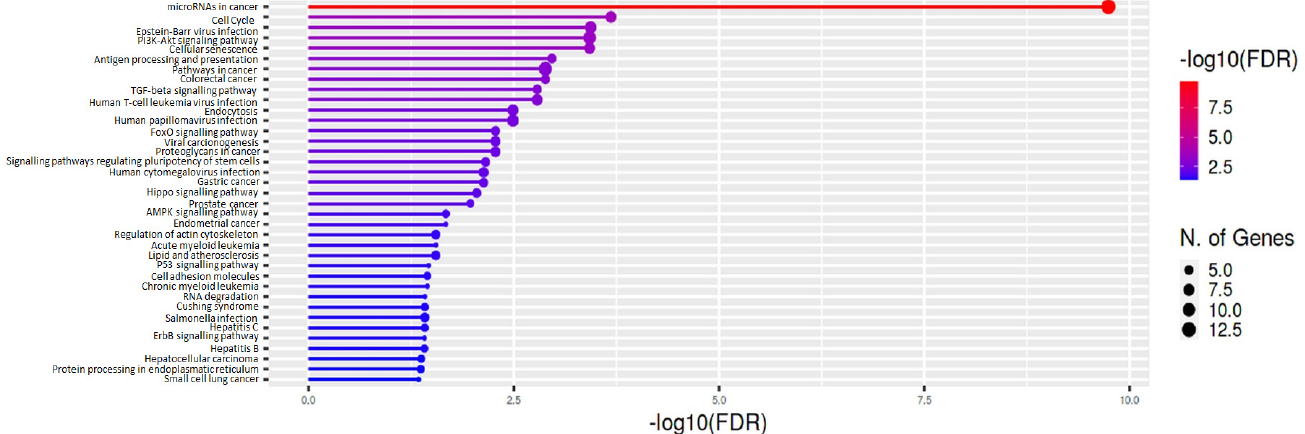
Figure 3. Enrichment analysis of KEGG pathways relative to validated target genes of miR-409-3p and miR-148a-3p. Bar plots show the significantly enriched functional categories ordered by p- value.